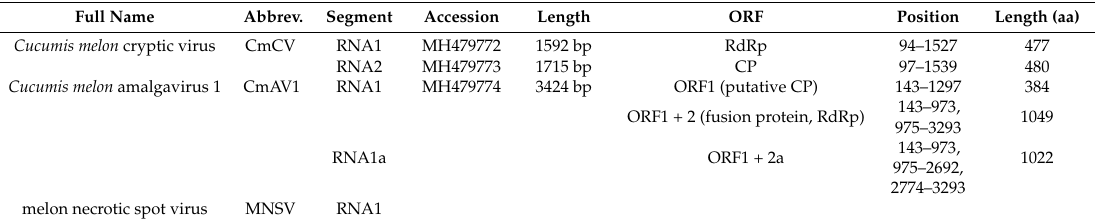
Figure 1. Symptoms of the melon leaves showing yellow vein in Heilongjiang Province in China. Table 1. Summary of the RNA viruses identified in the symptomatic melon leaves. ORF: open reading frame.